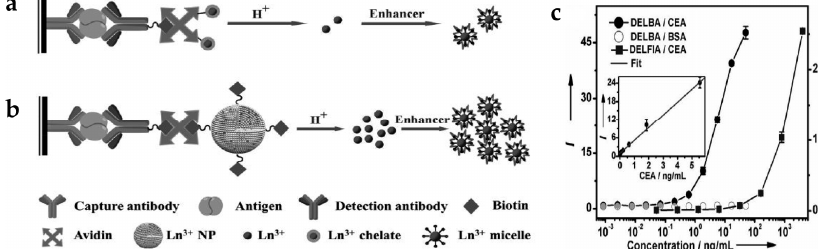
Figure 2. ( a ) Design concept of conventional dissociation-enhanced lanthanide fluoroimmunoassay (DELFIA) using lanthanide-chelates; ( b ) Schematic illustration of dissolution-enhanced luminescent bioassays (DELBA) using lanthanide NPs; ( c ) Titration data for the carcinoembryonic antigen (CEA) detection using DELFIA and DELBA. Reprinted with permission from [49].